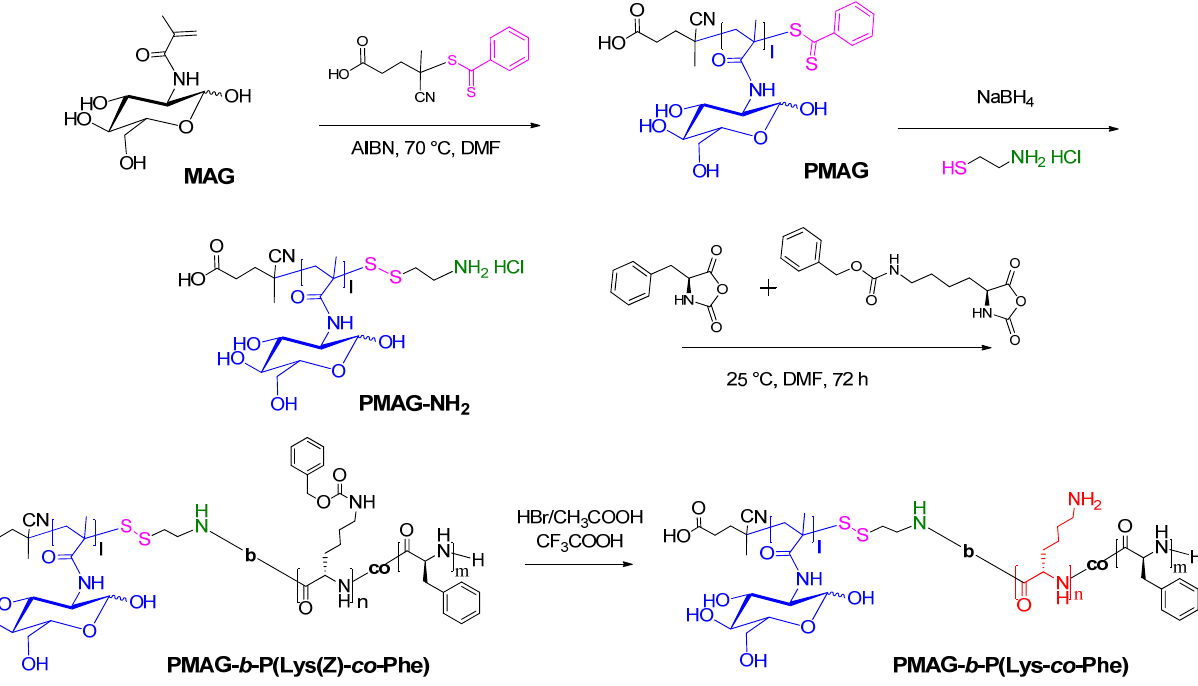
Figure 1. Scheme of synthesis of amphiphilic PMAG- b -P(Lys- co